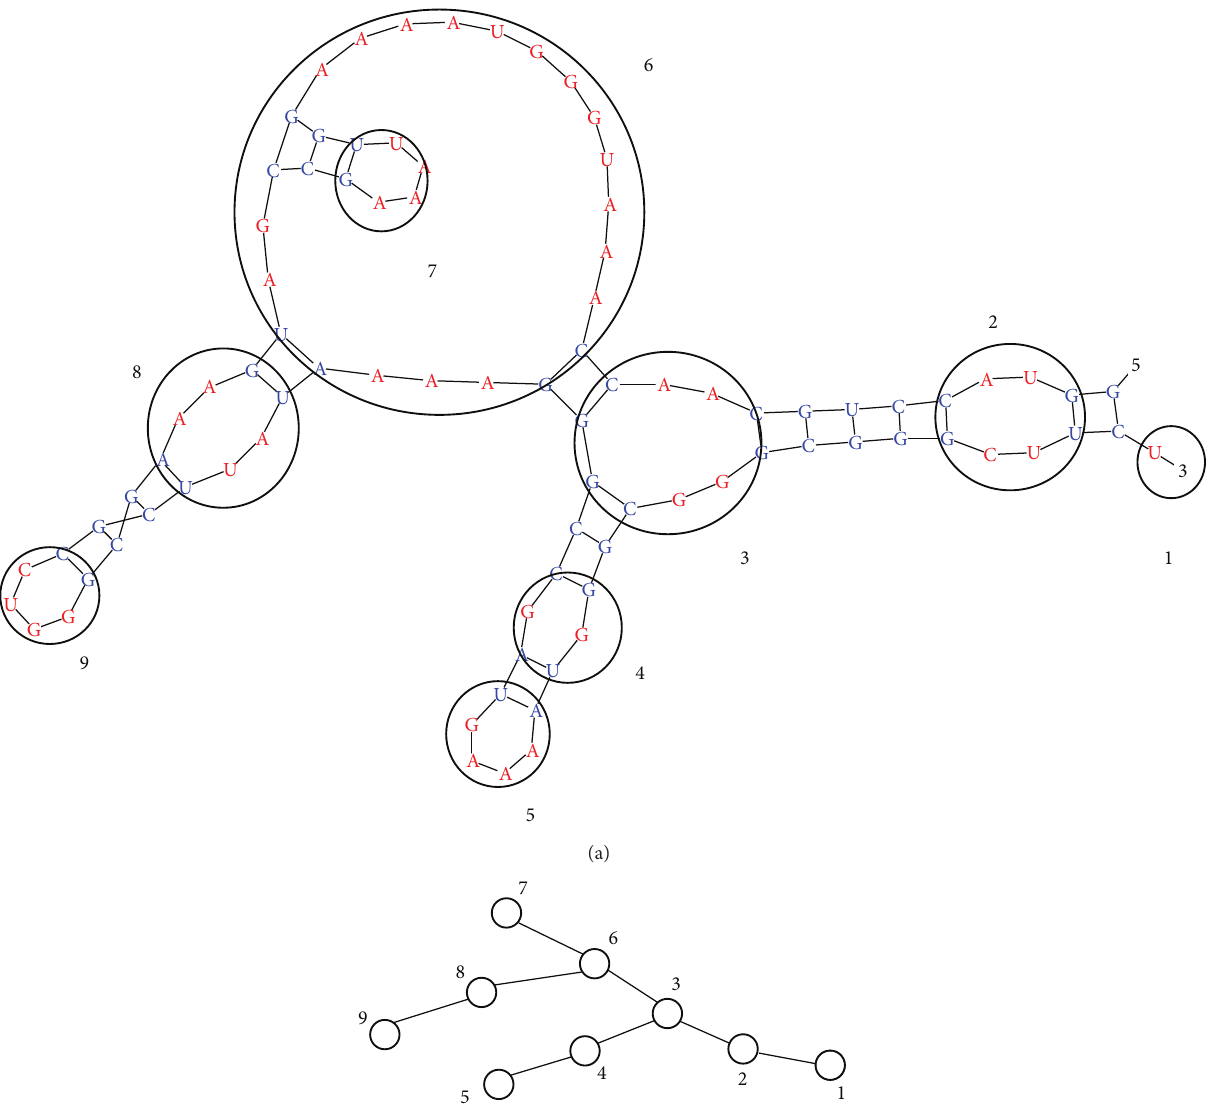
Figure 2: A fragment of the RNA secondary structure (a) and corresponding branched structure